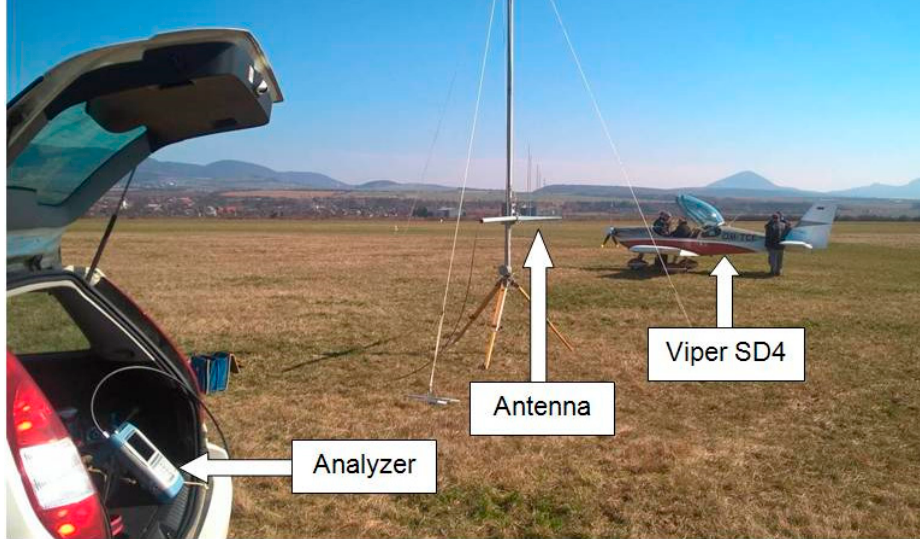
Figure 4. Arrangement of the measuring setup at Raž ň any Airport.